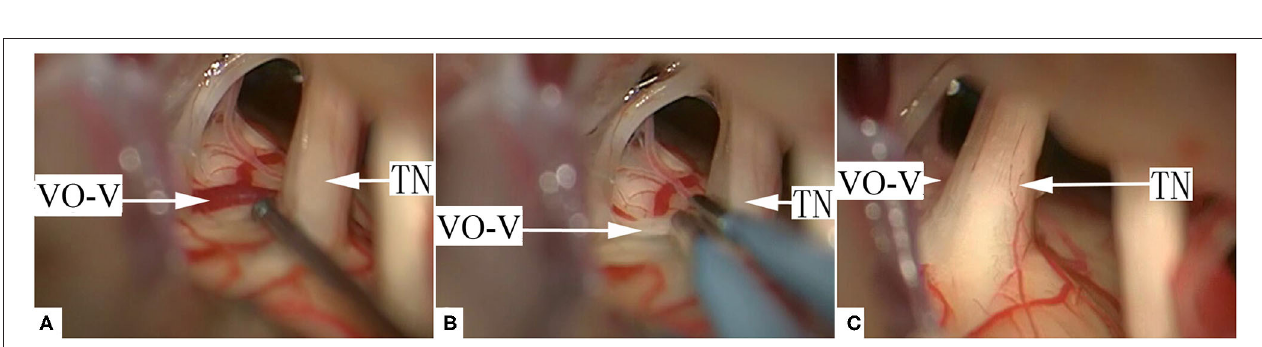
FIGURE 1 | Three types of venous offending on the ventral side of the root entrance/exit zone (VO-VREZ) based on anatomical relationship of the vein and the trigeminal nerve root entrance/exit zone. (A) The full route of the vein was covered by the root entrance/exit zone; (B) The vein went out laterally from the root; (C) The VO-VREZ ran through the root. TN, trigeminal nerve; BS, brain stem; VO-V, venous offending on the ventral side of root entrance/exit zone.